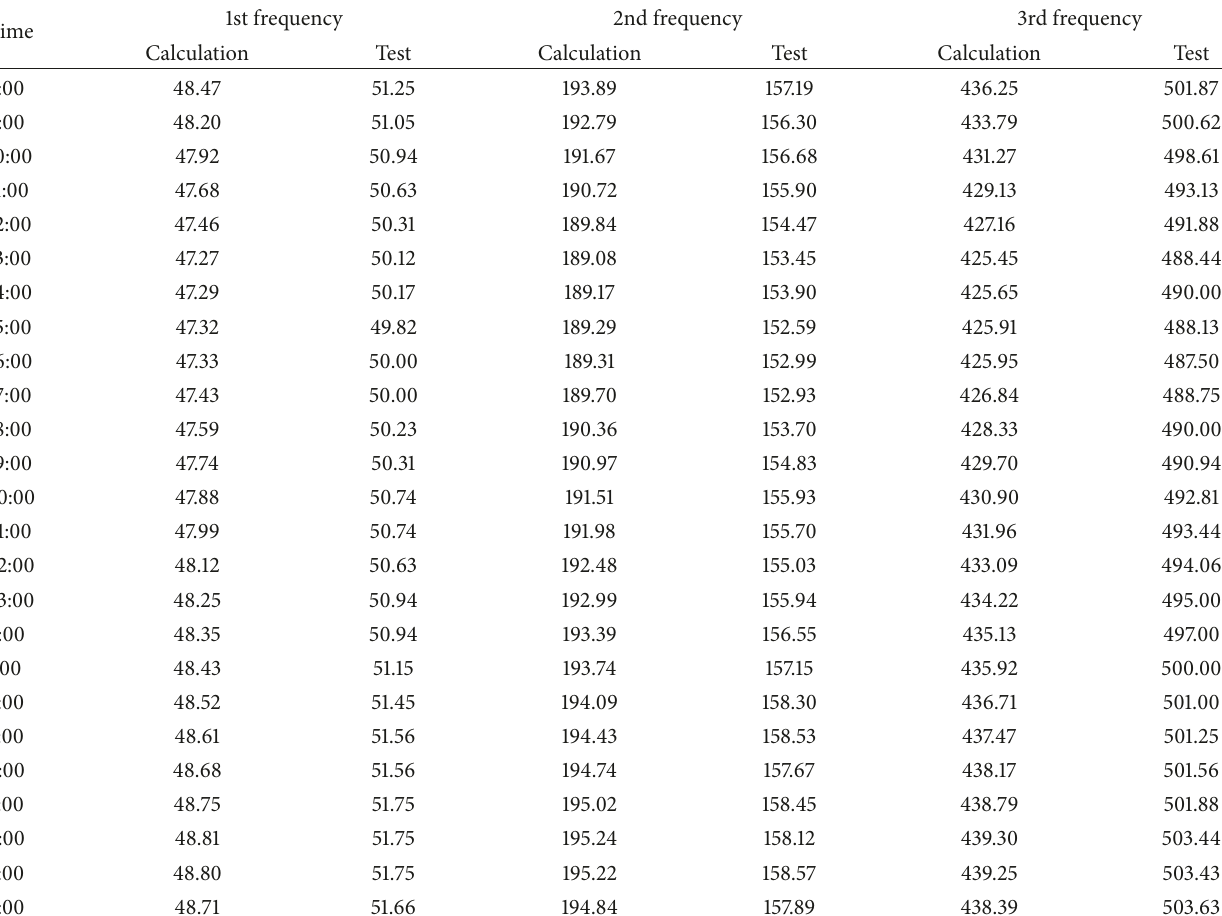
Table 2: Test and calculation results of the first three frequencies at different times.